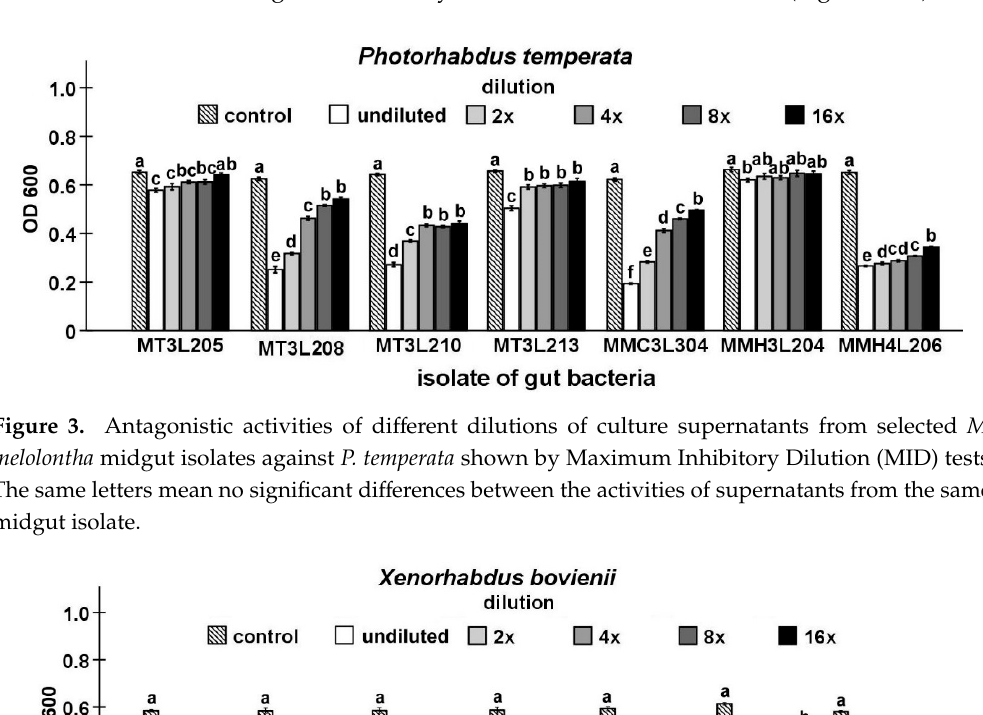
differences between the activities of supernatants from the same midgut isolate.*—no bacterial growth.